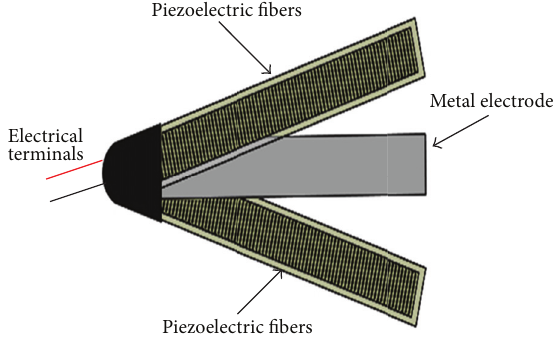
Figure 1: The schematical representation of the bimorph PZT piezoelectric energy harvester used in this